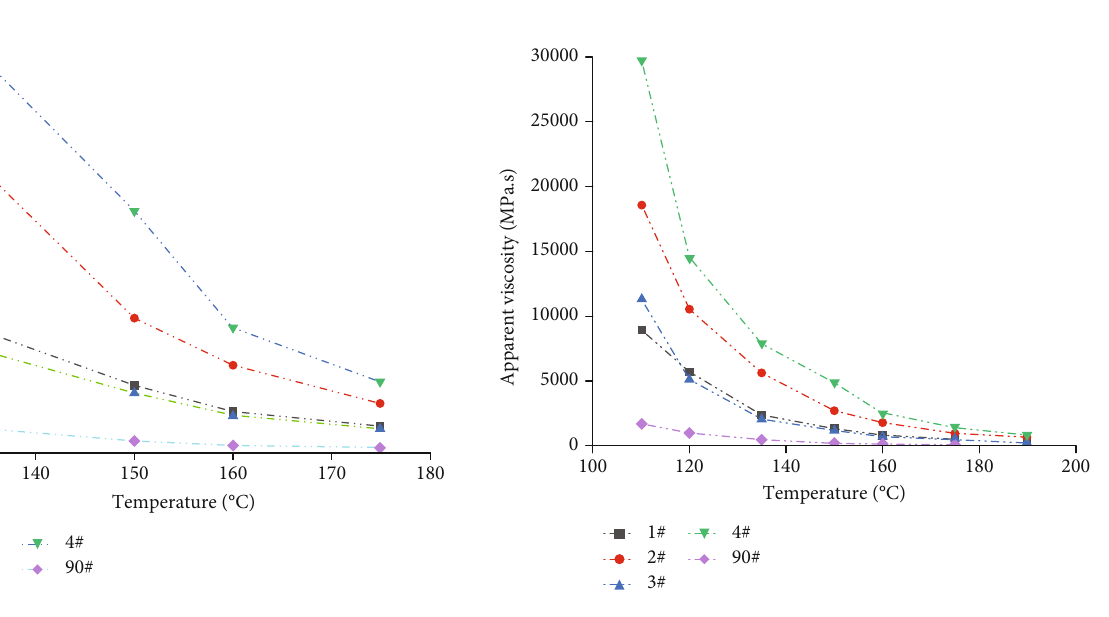
Figure 8: 135 ° C/175 ° C viscosity-temperature curve of tire rubber powder-modi fi ed asphalt.